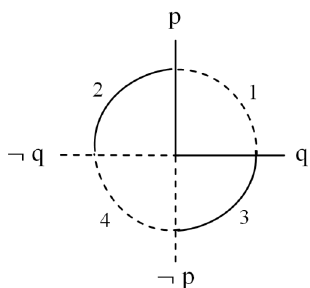
Table 6: Truth-table of incompatible Graph 6: Truth-graph of incompatible disjunctive